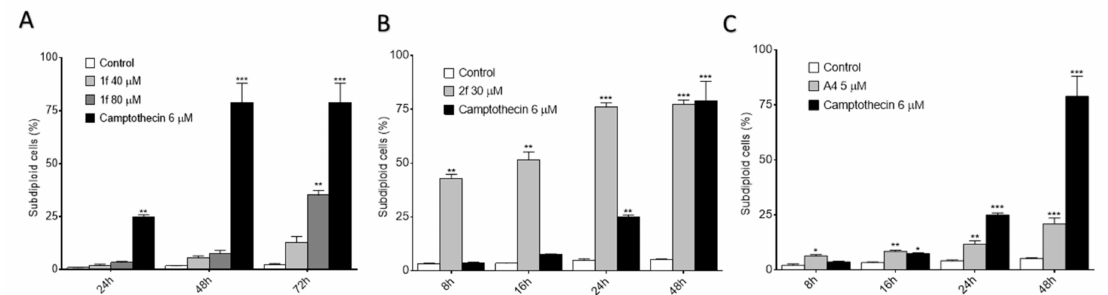
Figure 5. Percentage of subdiploid cells in MCF-7 cell cultures after treatment for the indicated time period with: 40 and 80 µ M of I.1f ( A ), 30 µ M of I.2f ( B ) and 5 µ M of II.2d ( C ). * Statistical significance with values of p < 0.05; ** statistical significance with values of p < 0.01; *** statistical significance with values of p < 0.001.